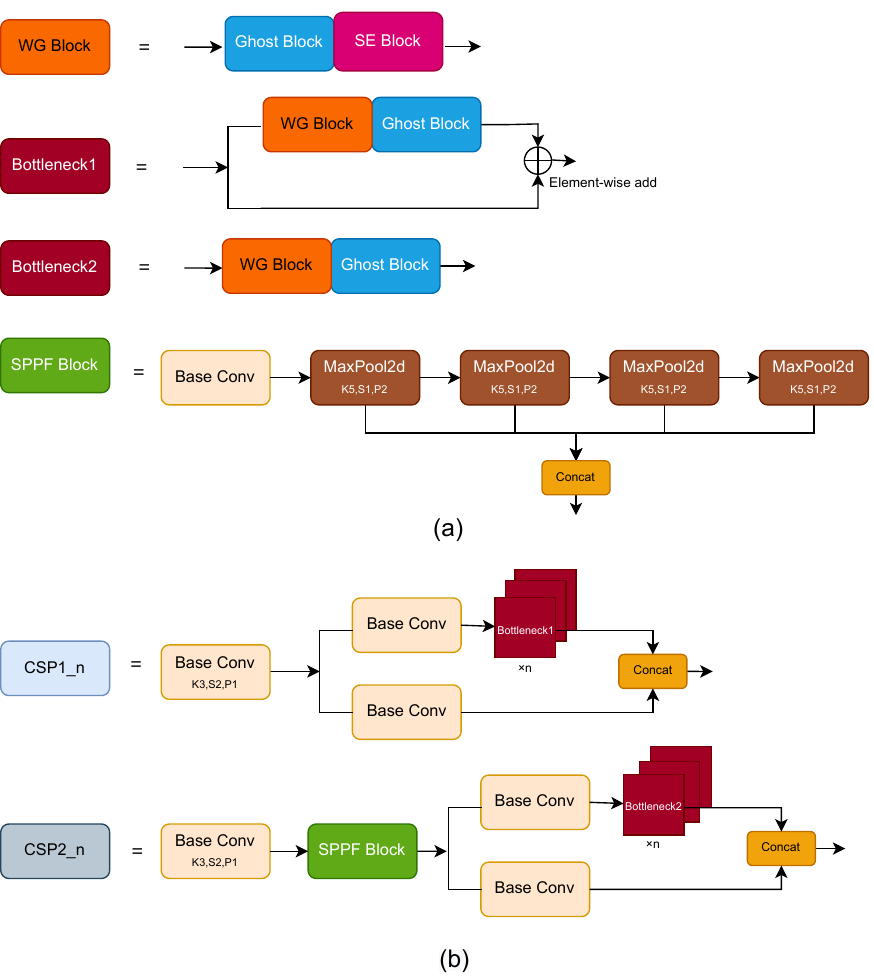
Figure 4. The details of the WG-CSP. ( a ) The structure of the WG Block, Bottleneck, and SPPF; ( b ) basic WGCSP Blocks in the WG-CSP consisting of the modules shown in ( a